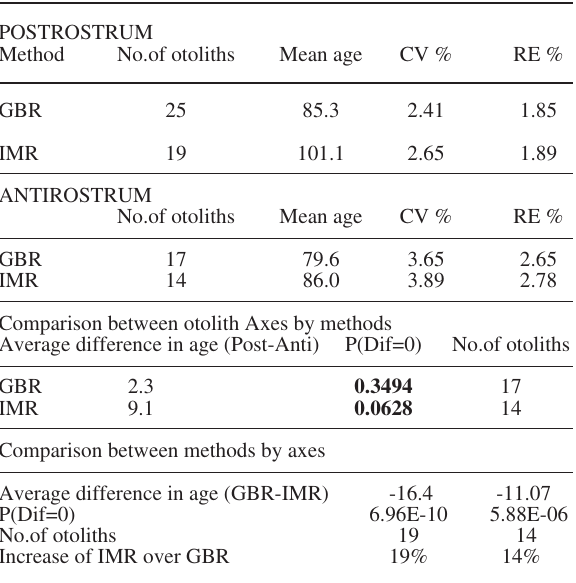
Table 3. – Average daily increments and precision obtained for the two age reading procedures (GBR and IMR) and for the otolith axes used for the examination and comparison of the different age read- ing results by paired t test (two tailed) on individual otolith’s age determination.